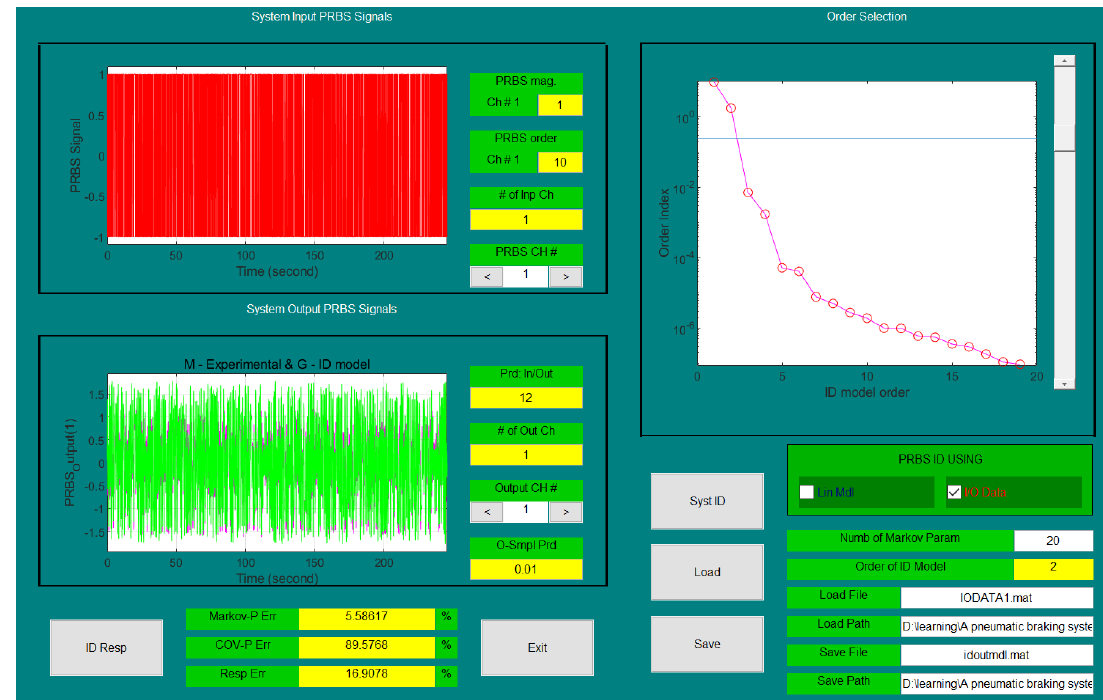
Figure 4. The identification results based on the chosen parameters.